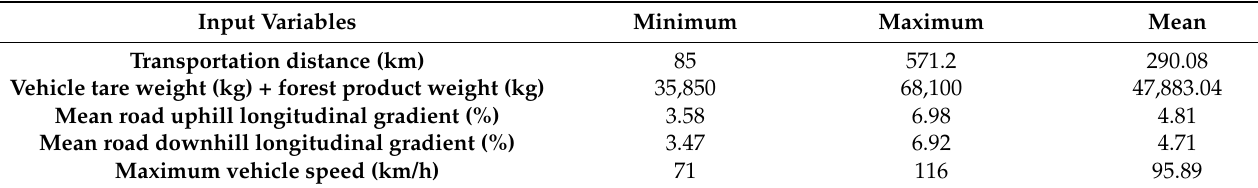
Table 9. Input variables description